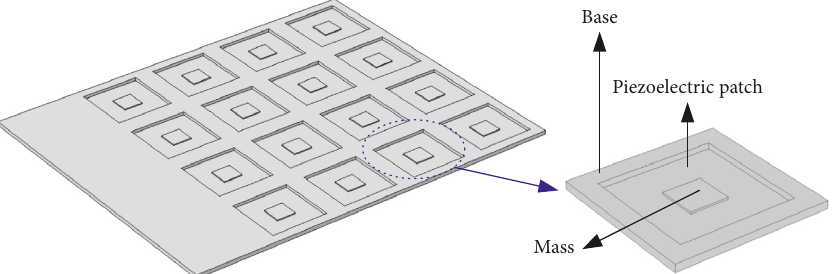
Figure 1: Basic configuration of a PMP-LR.